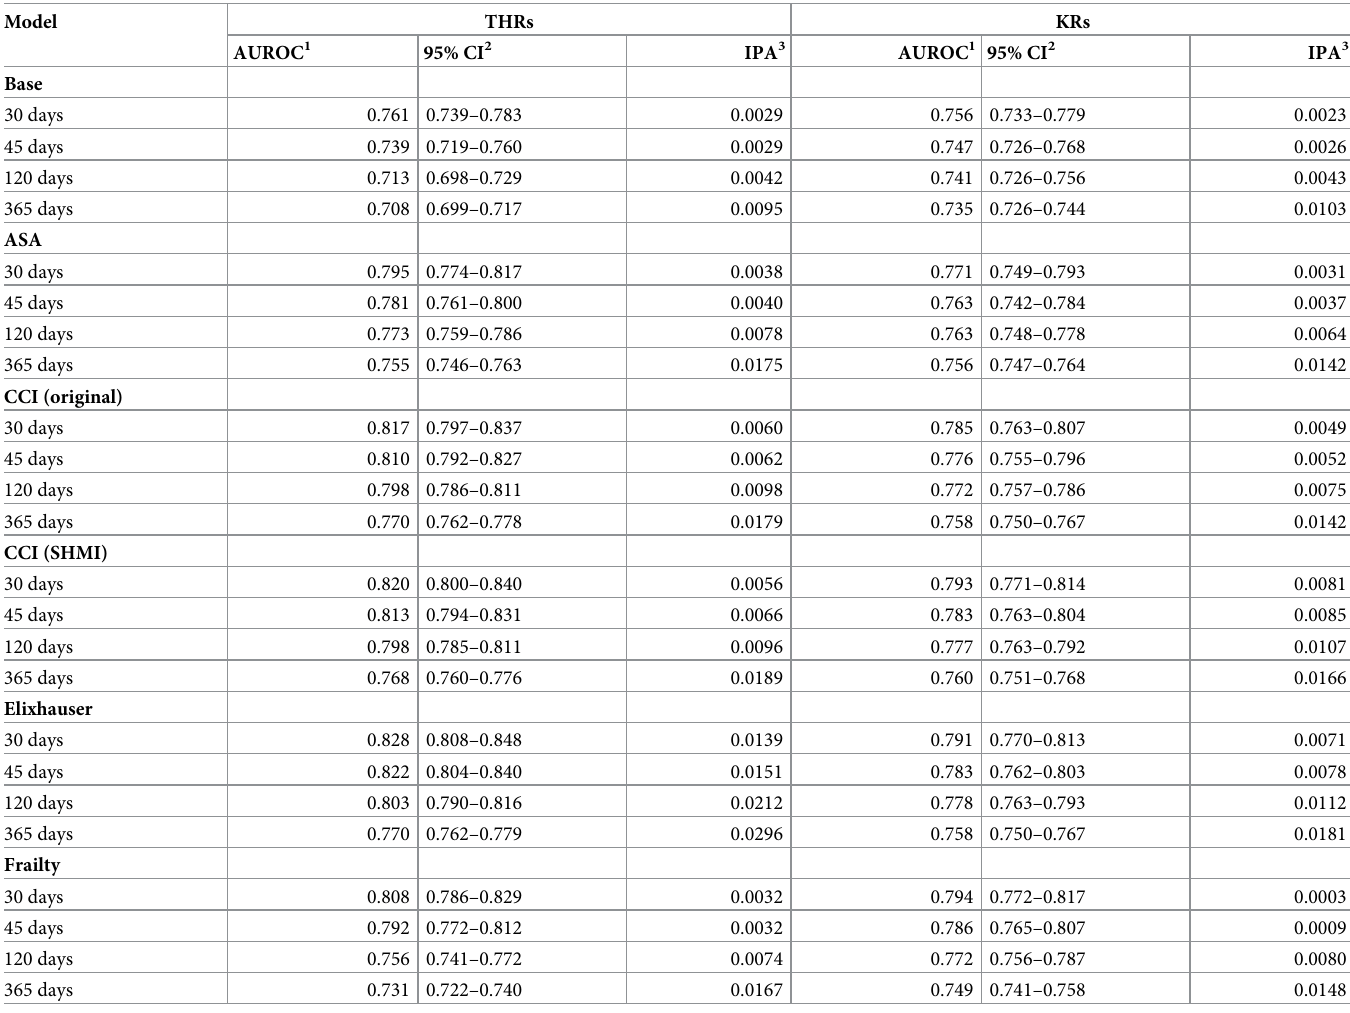
Table 4. The area under the ROC curve and IPA for ASA grade and all comorbidity scores for models of 30, 45, 90, 120 and 365-day mortality after THR and KR, adjusted for age and gender.